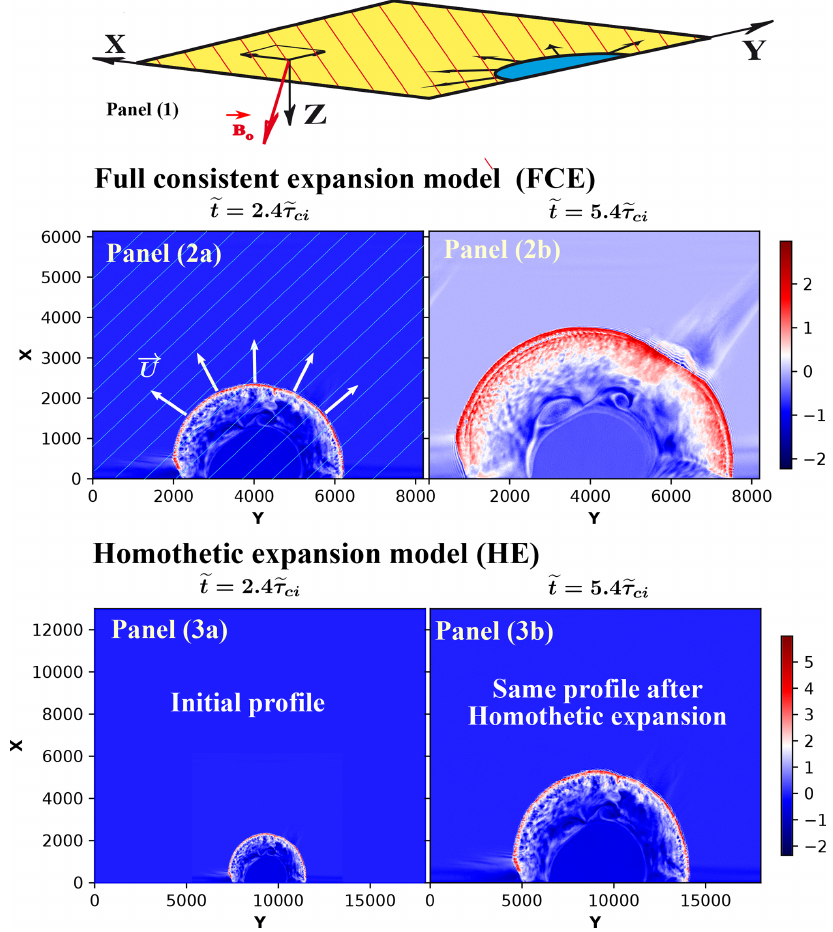
Figure 1. Panel (1) plots the simulation plane geometry; the (cid:101) B o magnetostatic field is mainly outside and directed downward from the plane. Panels (2a, b) illustrate the evolution of the magnetic field (cid:101) B tz in the fully consistent expansion (FCE) model (time dependent), respectively, at (cid:101) t init = 2 . 4 (cid:101) τ ci and (cid:101) t simul = 5 . 4 (cid:101) τ ci . In panel (2a) , used as a reference, the vector velocity (cid:101) U = (cid:101) v shock has been superimposed to illustrate the shock front propagation (white thick arrows); the arrow length is not at the right scale. In addition, the projection of the (cid:101) B o magnetic field lines has been reported (oblique white thin lines). Panels (3a, b) illustrate one example of the curved magnetic field (cid:101) B tz in the homothetic expansion (HE) model (time independent), where the shock profile is fixed in time but expands in space via an expanding factor proportional to the shock front velocity v shock × t ; this shock profile has been chosen at the time (cid:101) t init = 2 . 4 (cid:101) τ ci of the self-consistent simulation. From this time, the shock front dilates by a factor of 2 . 6 compared to its initial